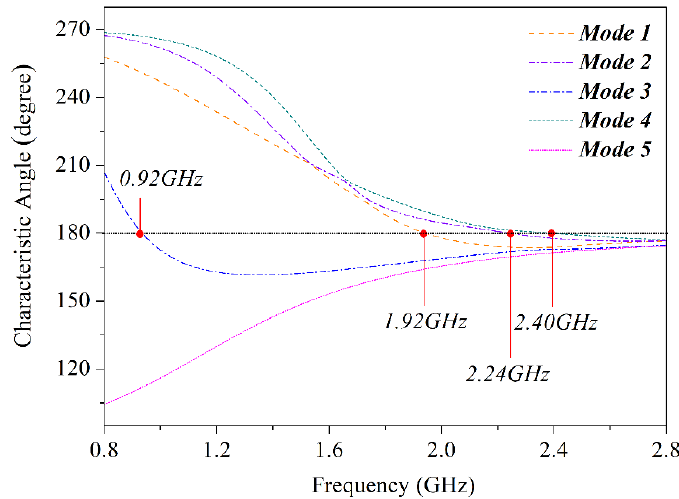
Figure 2. Characteristic angles of the first five modes of the structure: Mode 3 at 0.92 GHz, Mode 1 at 1.92 GHz, Mode 2 at 2.24 GHz, and Mode 4 at 2.4 GHz.